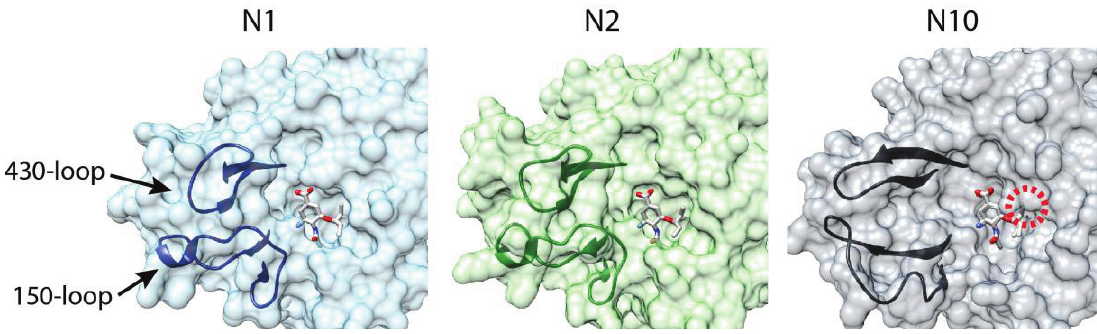
Figure 2. Comparison of the NA active site. Surface representations of the active sites for N1 (2HU4) and N2 (2QWK) in the presence of the neuraminidase inhibitor oseltamivir [59,60]. The substrate binding pocket is framed by the 150- and 430-loops. The bat influenza virus N10 active site (4FVK) is shown with oseltamivir from the N1 and N2 structures superimposed. The substrate binding pocket is dramatically opened relative to N1 and N2. A predicted clash between N10 and the modeled oseltamivir is denoted with a red